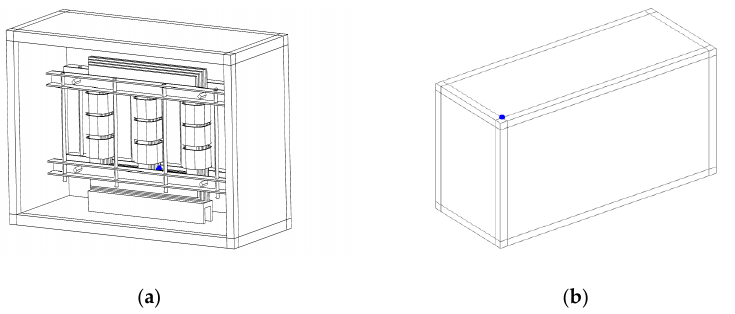
Figure 8. The location of the transformer observation point; they should be listed as: ( a ) The position of the core point; and ( b )The position of the transformer enclosure point.